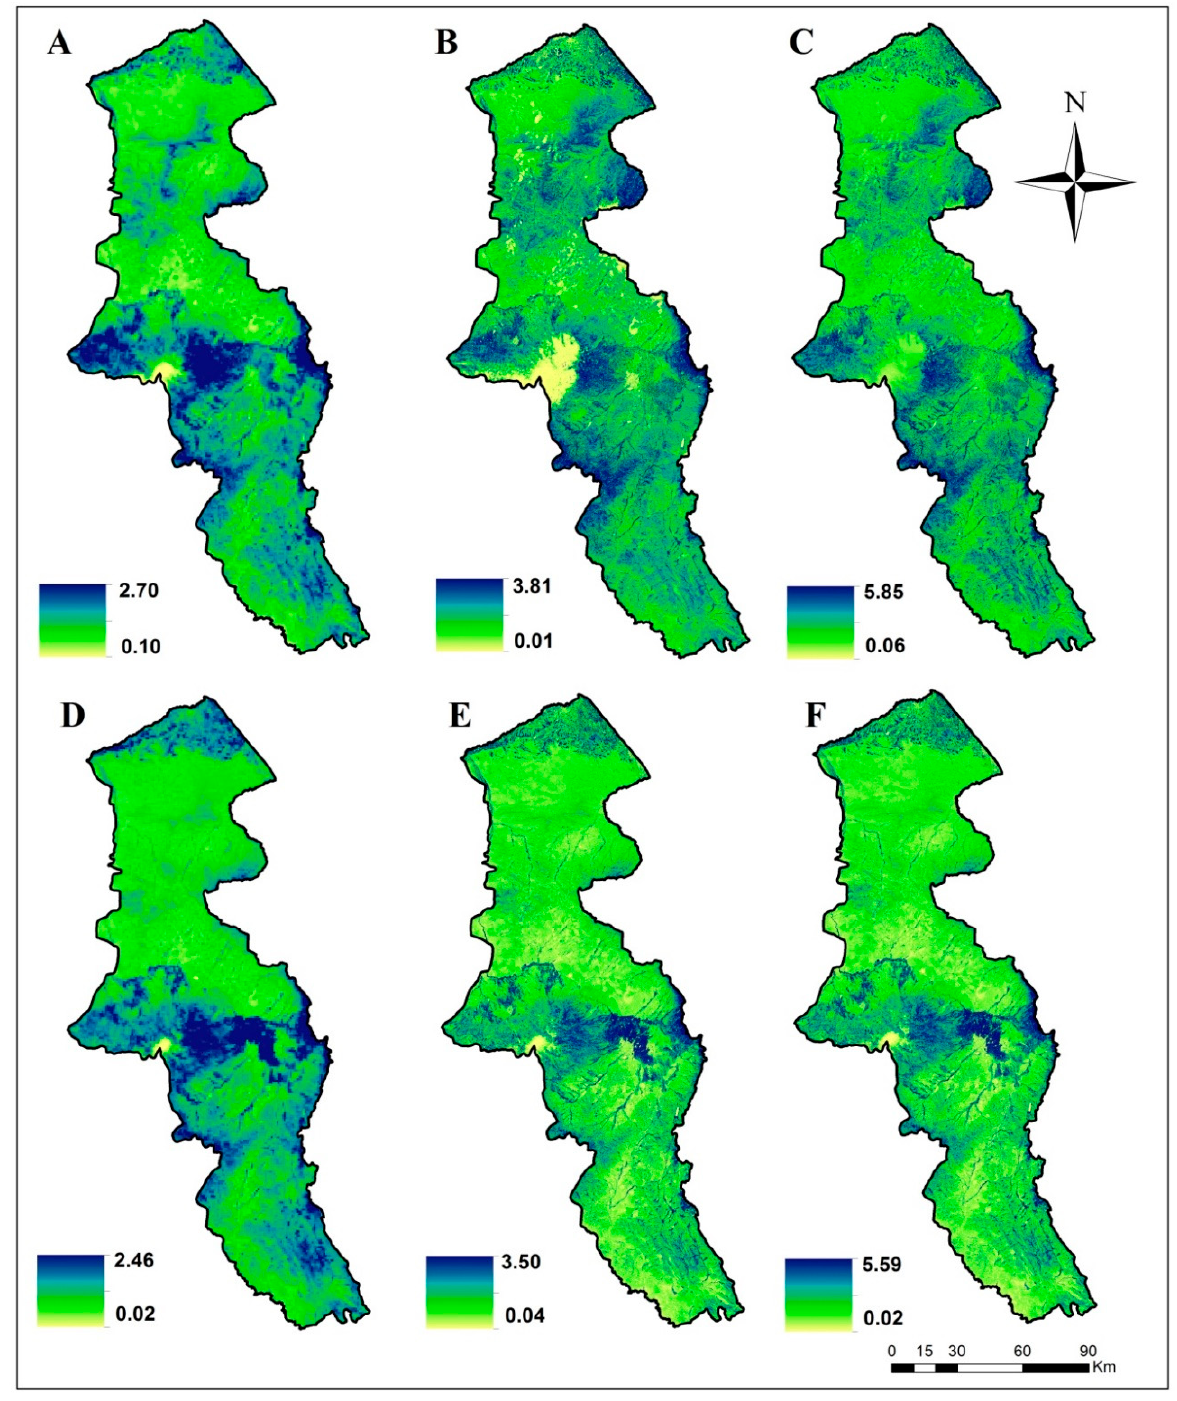
Figure 5. Maps of LAI produced from different vegetation indices in June (up) and July (down), 2020 ( A : EVI G -LAI (June), B : EVI E -LAI (June), C : NDVI E -LAI (June), D : EVI G -LAI (July), E : EVI E -LAI (July), F : NDVI E -LAI (July)). Table 5. Remote sensing LAI values for different sampling months.